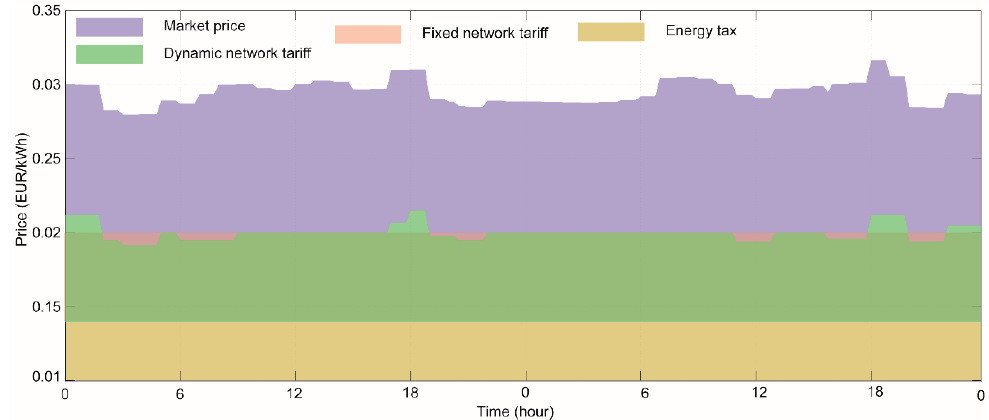
Figure 7. Electricity price breakdown in different cases.